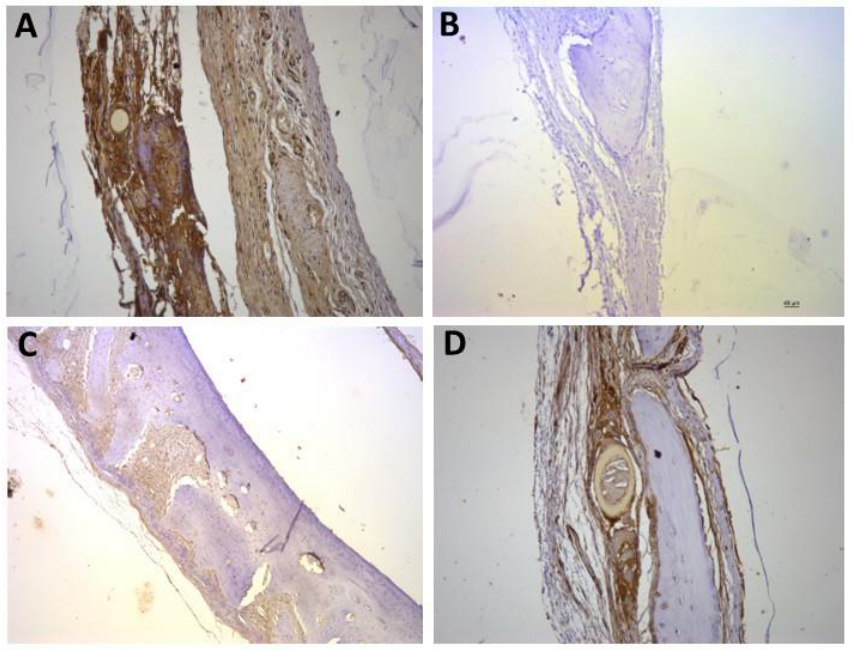
Figure 4. Representative immunohistochemistry images for OPG staining. ( A ) control group; ( B ) negative control; ( C ) group 2 with marking considered (+); ( D ) group 6 with marking considered (++++); the most observed staining pattern among the groups analyzed. Harris’ hematoxylin counterstained. Scale bar: 46 µm.